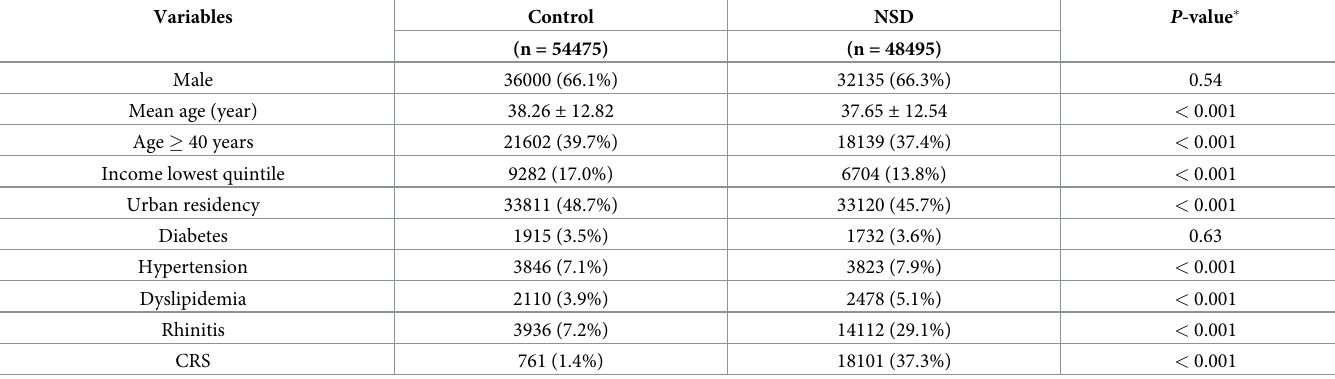
Table 2. Demographic characteristics of patients with NSD and the control